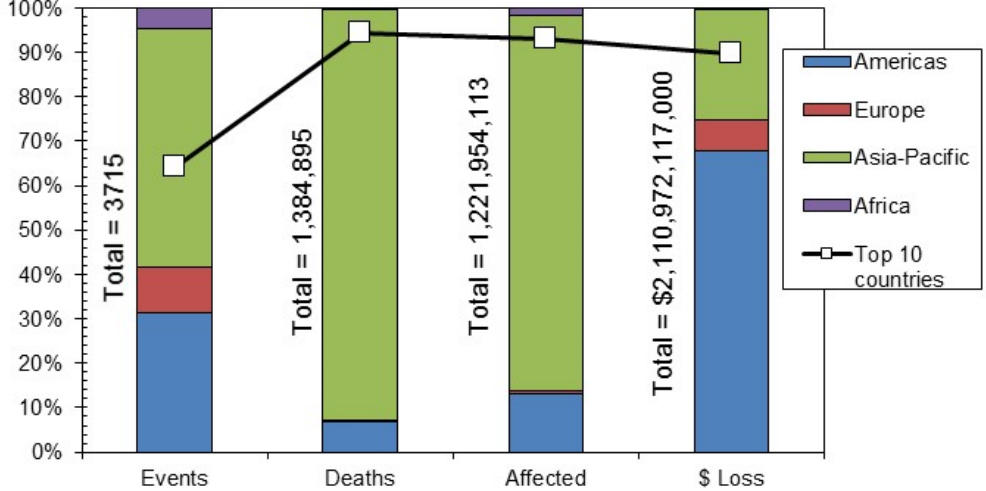
Figure 6. Distribution of events, deaths, persons affected, and economic loss due to metrological disasters (storms only) across the globe during the period 1900–2020 AD (Data Source: [57]).